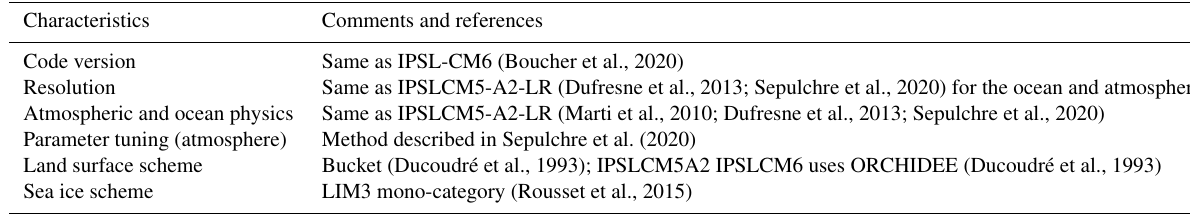
Table 1. IPSL-CM6-SW-VLR compared to IPSLCM5-A2-LR and IPSL-CM6.